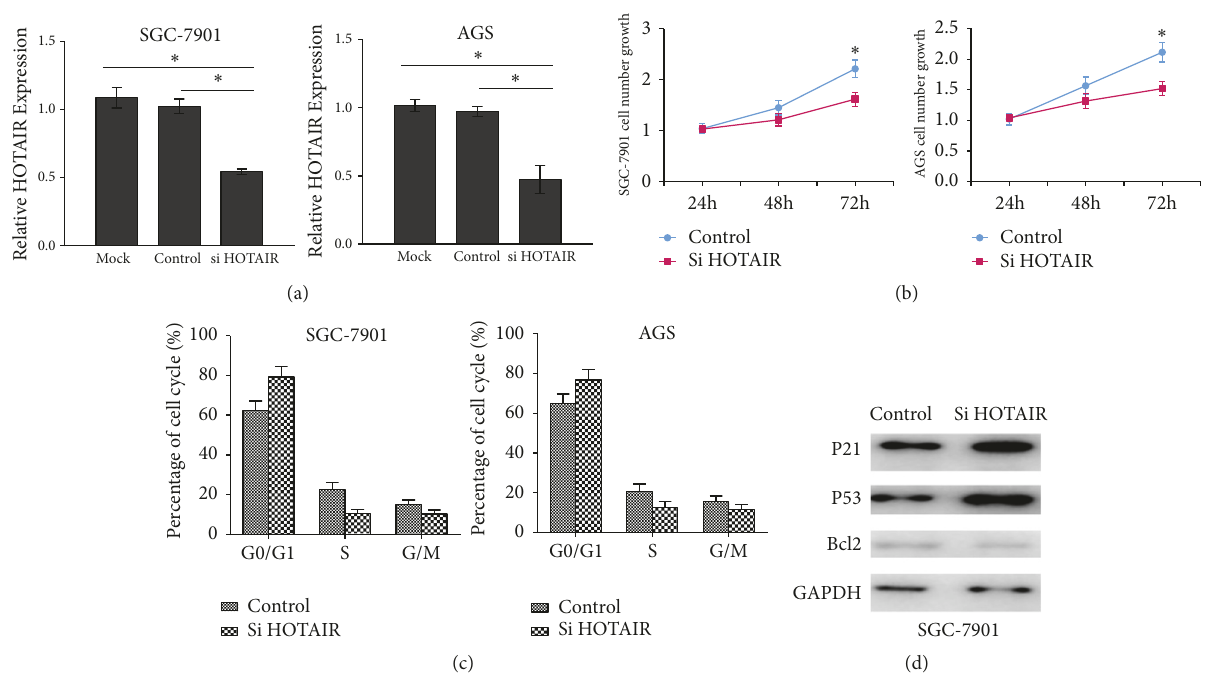
Figure 3: The effects of HOTAIR siRNA-transfection on GC cell proliferation. (a) The efficiency of HOTAIR siRNA transfection in SGC-7901 and AGS. (b) The effects of HOTAIR knockdown on SGC-7901 and AGS cell growth. (c) The effects of HOTAIR knockdown on cell cycle distribution in SGC-7901 and AGS cells. (d) The effects of HOTAIR knockdown on the protein levels of P21, P53, and Bcl2 in SGC-7901